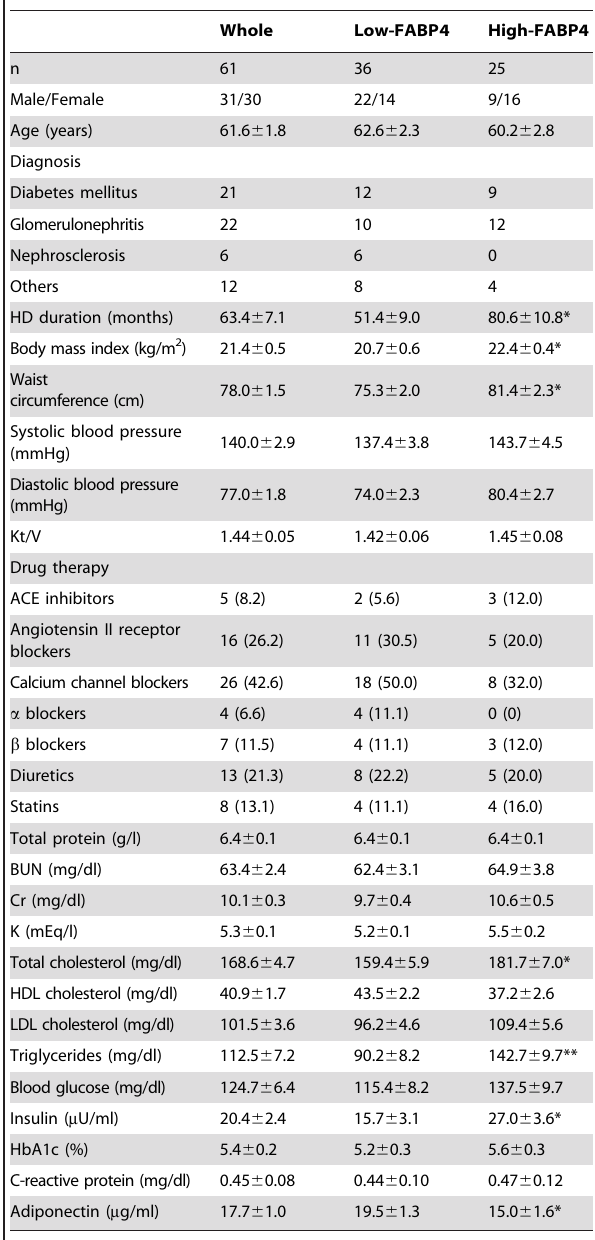
Table 3. Basal and biochemical characteristics of 61 patients. Table 4. Cox proportional hazard model for prognosis at 7 year